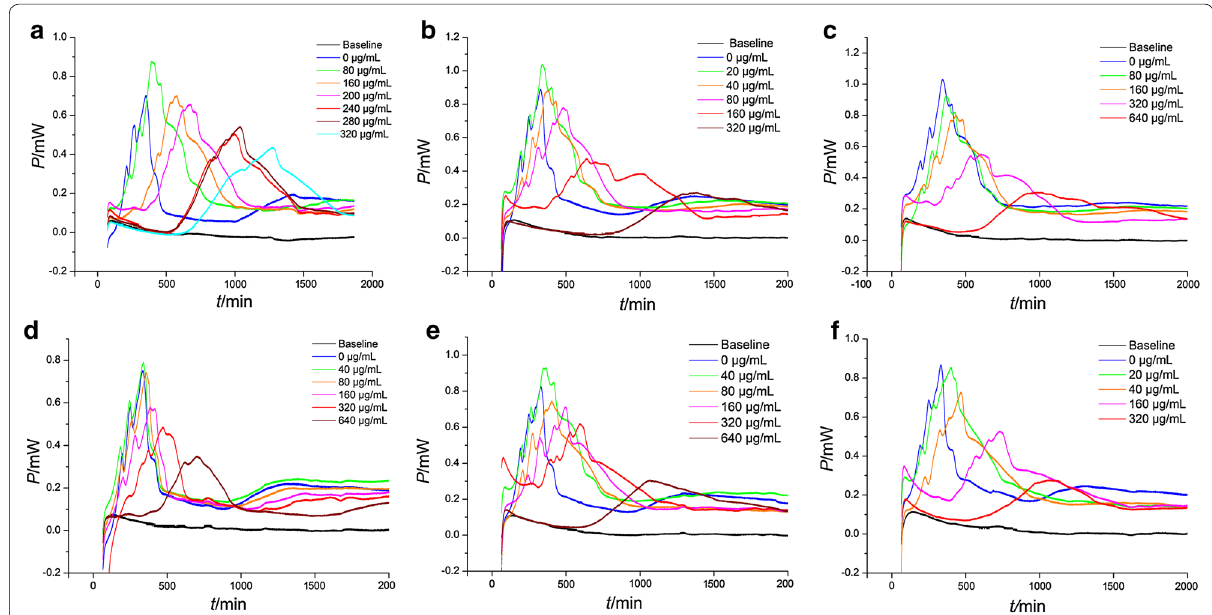
Fig. 2 The power–time curves of drug-resistant E. coli growth with six samples from the leaves of D. dao. a Sample S1; b sample S2; c sample S3; d sample S4; e sample S5; f sample